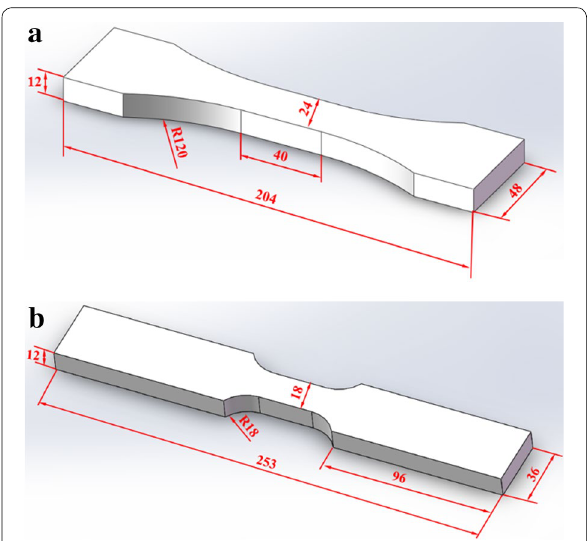
Figure 1 Geometry and dimensions in millimeters of specimens for: a LCF tests; b HCF tests